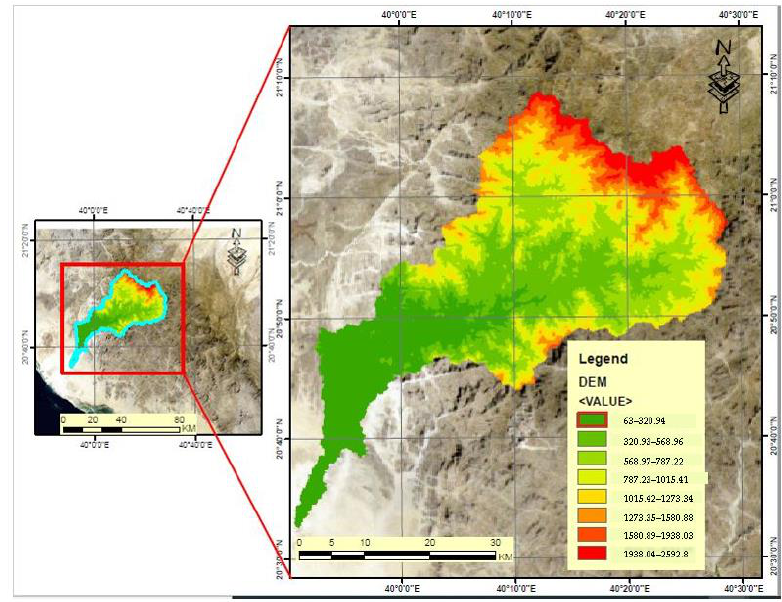
Figure 1. General location map and digital elevation model (DEM) of Wadi Yalamlam.